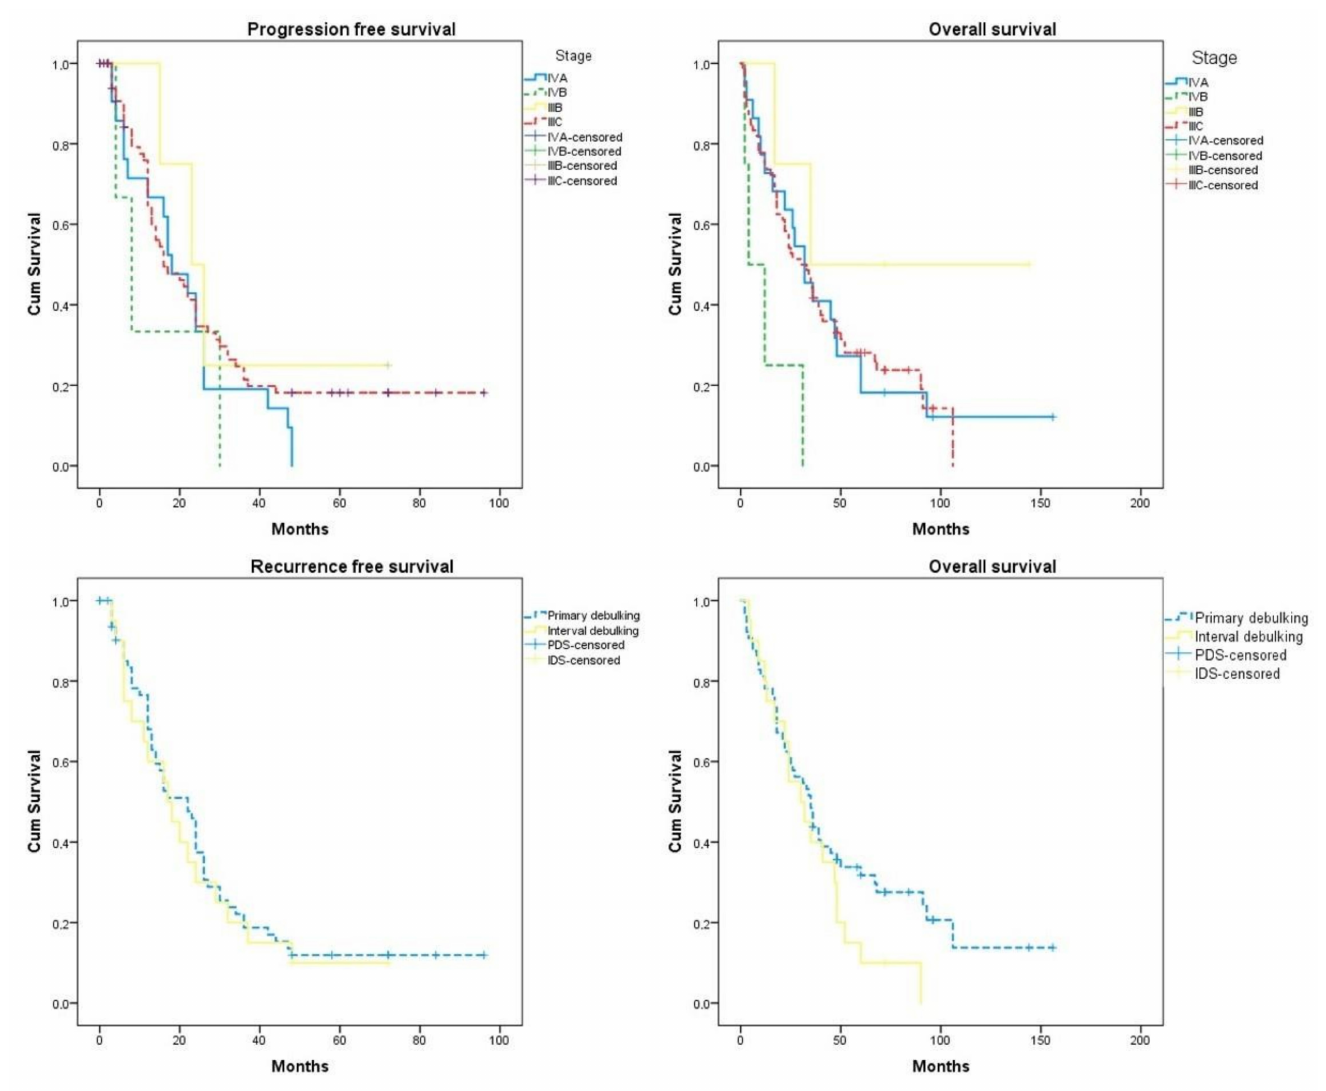
Figure 1. Progression-free survival and overall survival according to the stage of the disease and timing of surgery (primary debulking vs. interval debulking). Differences in overall survival rates start to differentiate from the 50th month ( log-rank =